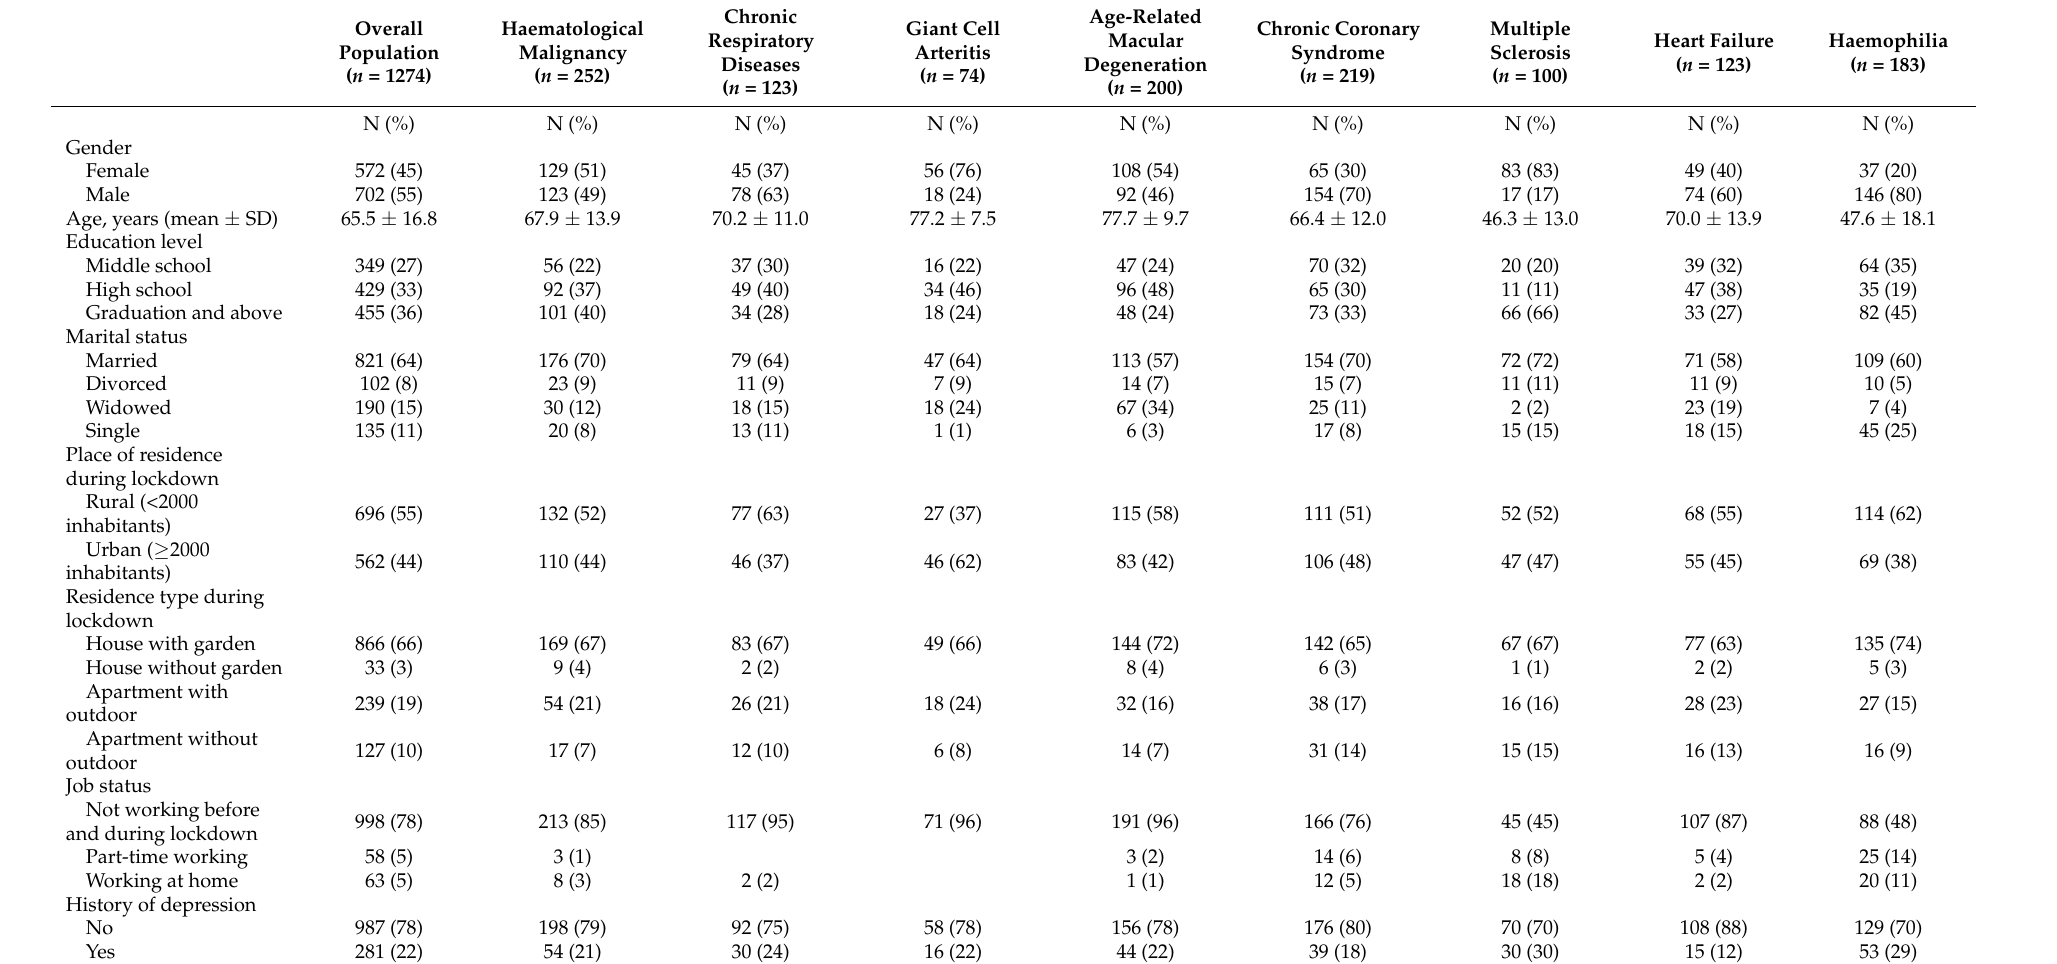
Table 1. Baseline patient